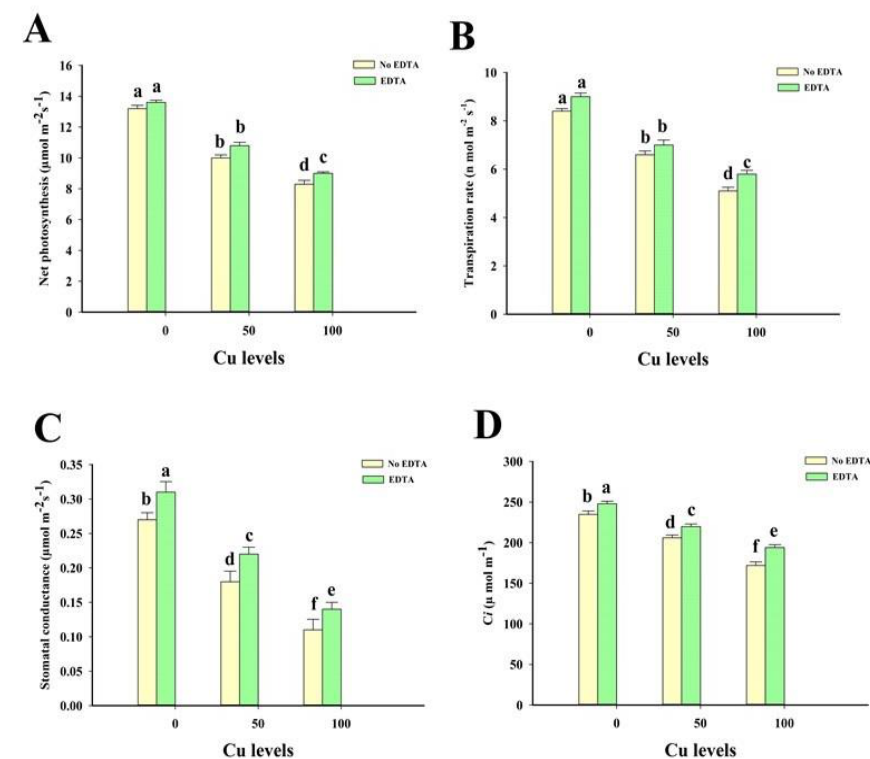
Figure 1. Effect of different concentrations of Cu with or without the application of EDTA on net photosynthesis ( A ), transpiration rate ( B ), stomatal conductance ( C ) and intercellular CO 2 ( D ) in the leaves of C. capsularis seedlings grown in solution medium with increasing Cu concentrations (0, 50 and 100 µ M) treated with and without 3-mM EDTA. The given values are means ± SD (n = 3). One-way ANOVA was performed and means differences were tested by highest significant difference HSD ( P < 0.05). Different lowercase letters in figure indicate significant difference between the treatments.